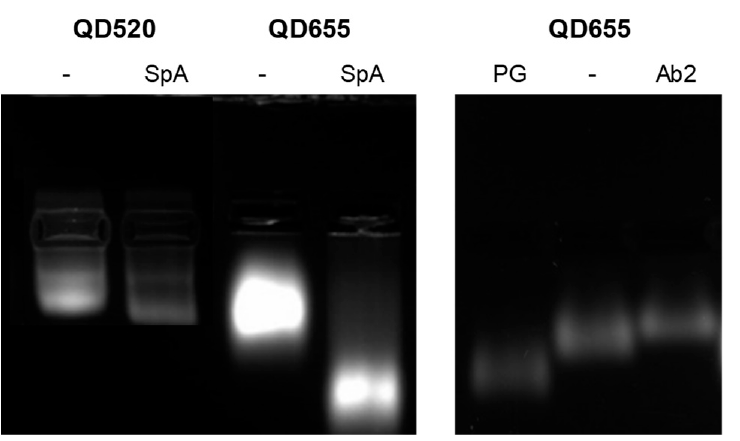
Figure 4. Electrophoretic mobility of unconjugated QDs, QD bioconjugates and commercially available QD-Ab2.